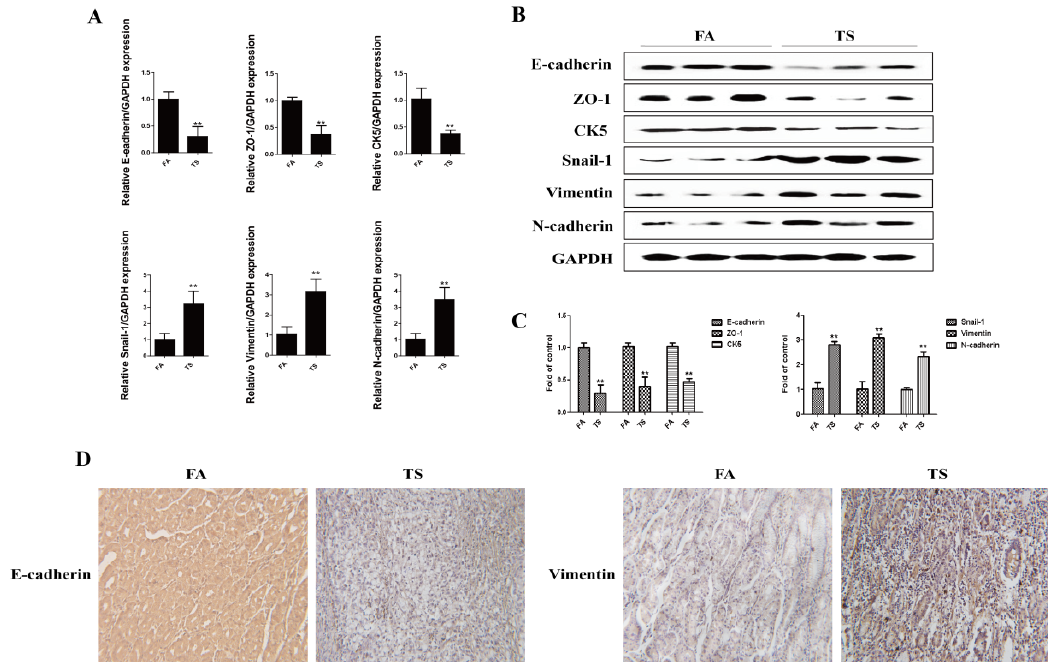
Figure 1. Tobacco smoke induced alterations in the expression of epithelial ‐ mesenchymal